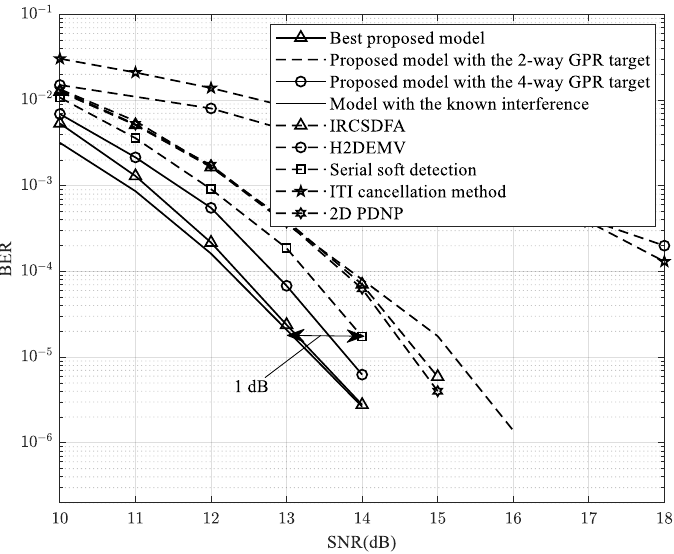
Figure 9. BER performance of the proposed model and models from previous works.